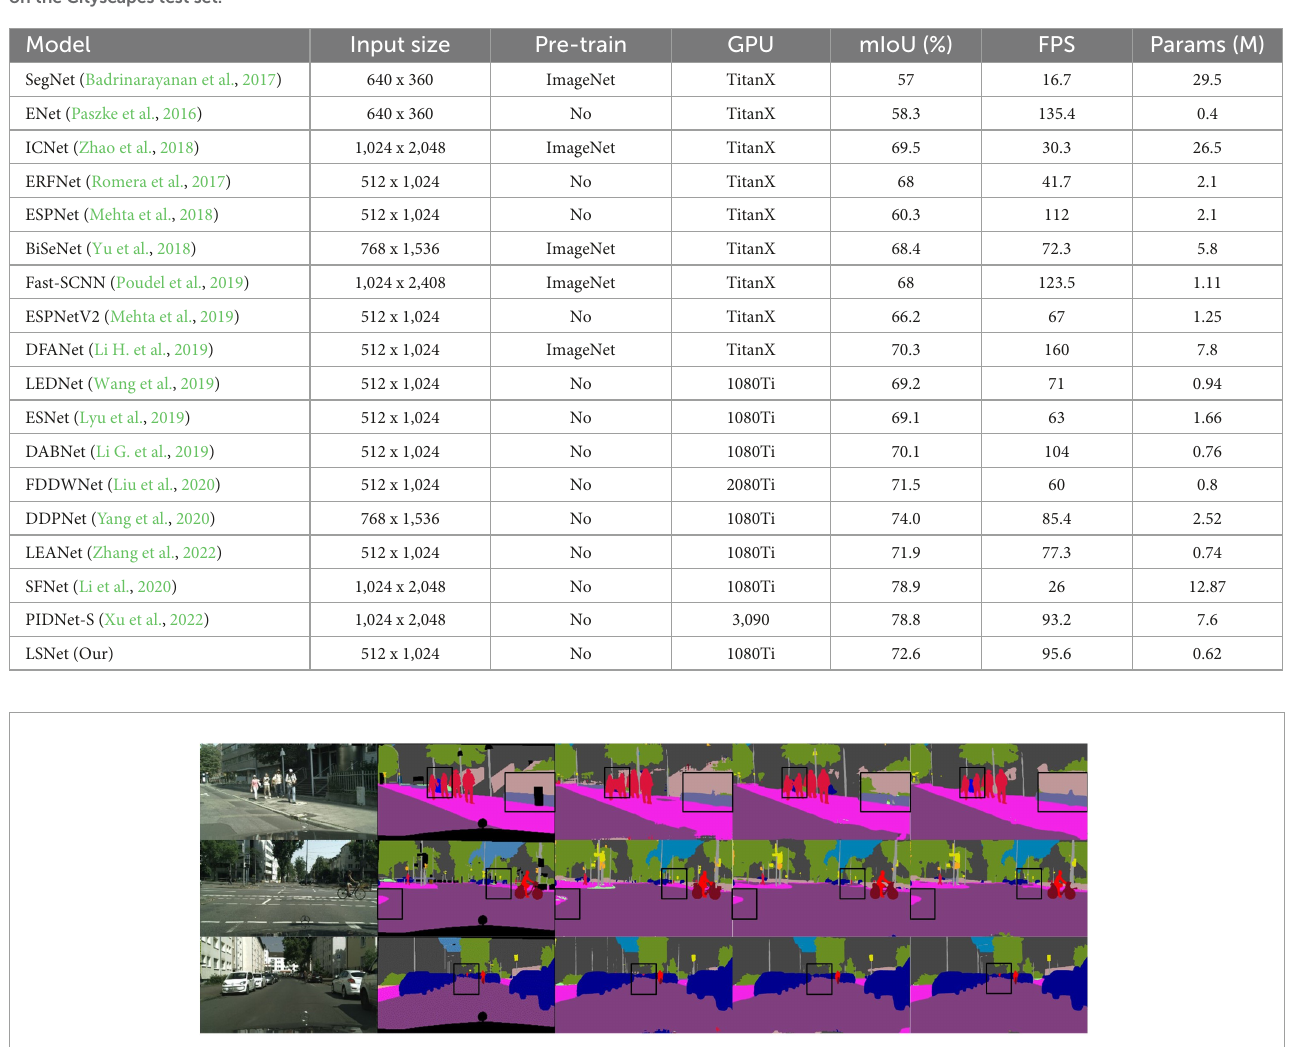
FIGURE5 Some visual comparisons on the Cityscapes validation set. From left to right are input images, ground truth, predicted results from LEDNet, DABNet, and our lightweight semantic segmentation network (LSNet).